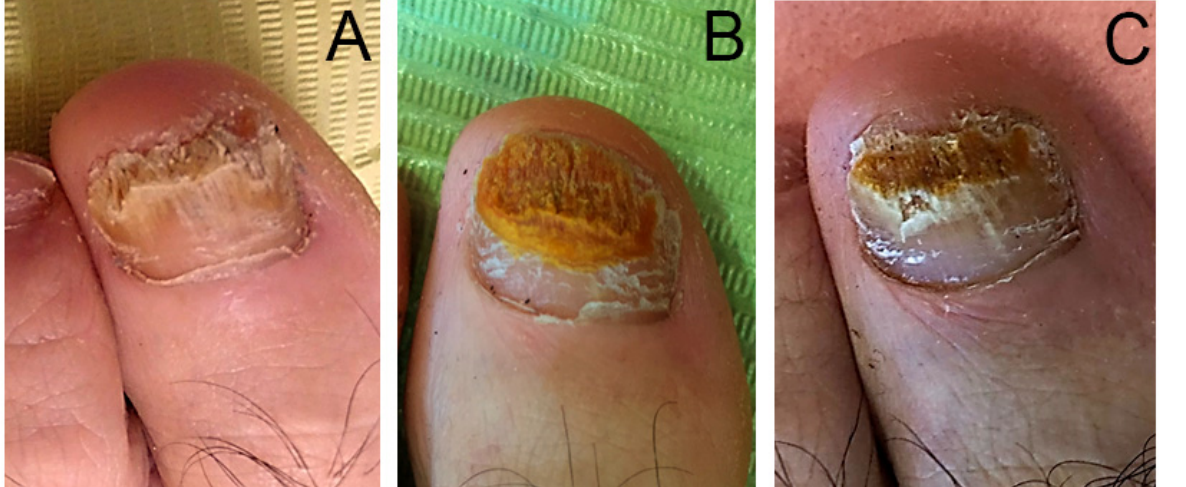
Figure 3. Evolution of the nail during treatment with 60% nitric acid of distal subungual onychomycosis (DSO) (A before - C after). Severe onychomycosis according to the OSI, pre-treatment. Improvement after treatment during sessions was observed ( A – C ) although the OSI score did vary post treatment maintains the same level of severity.